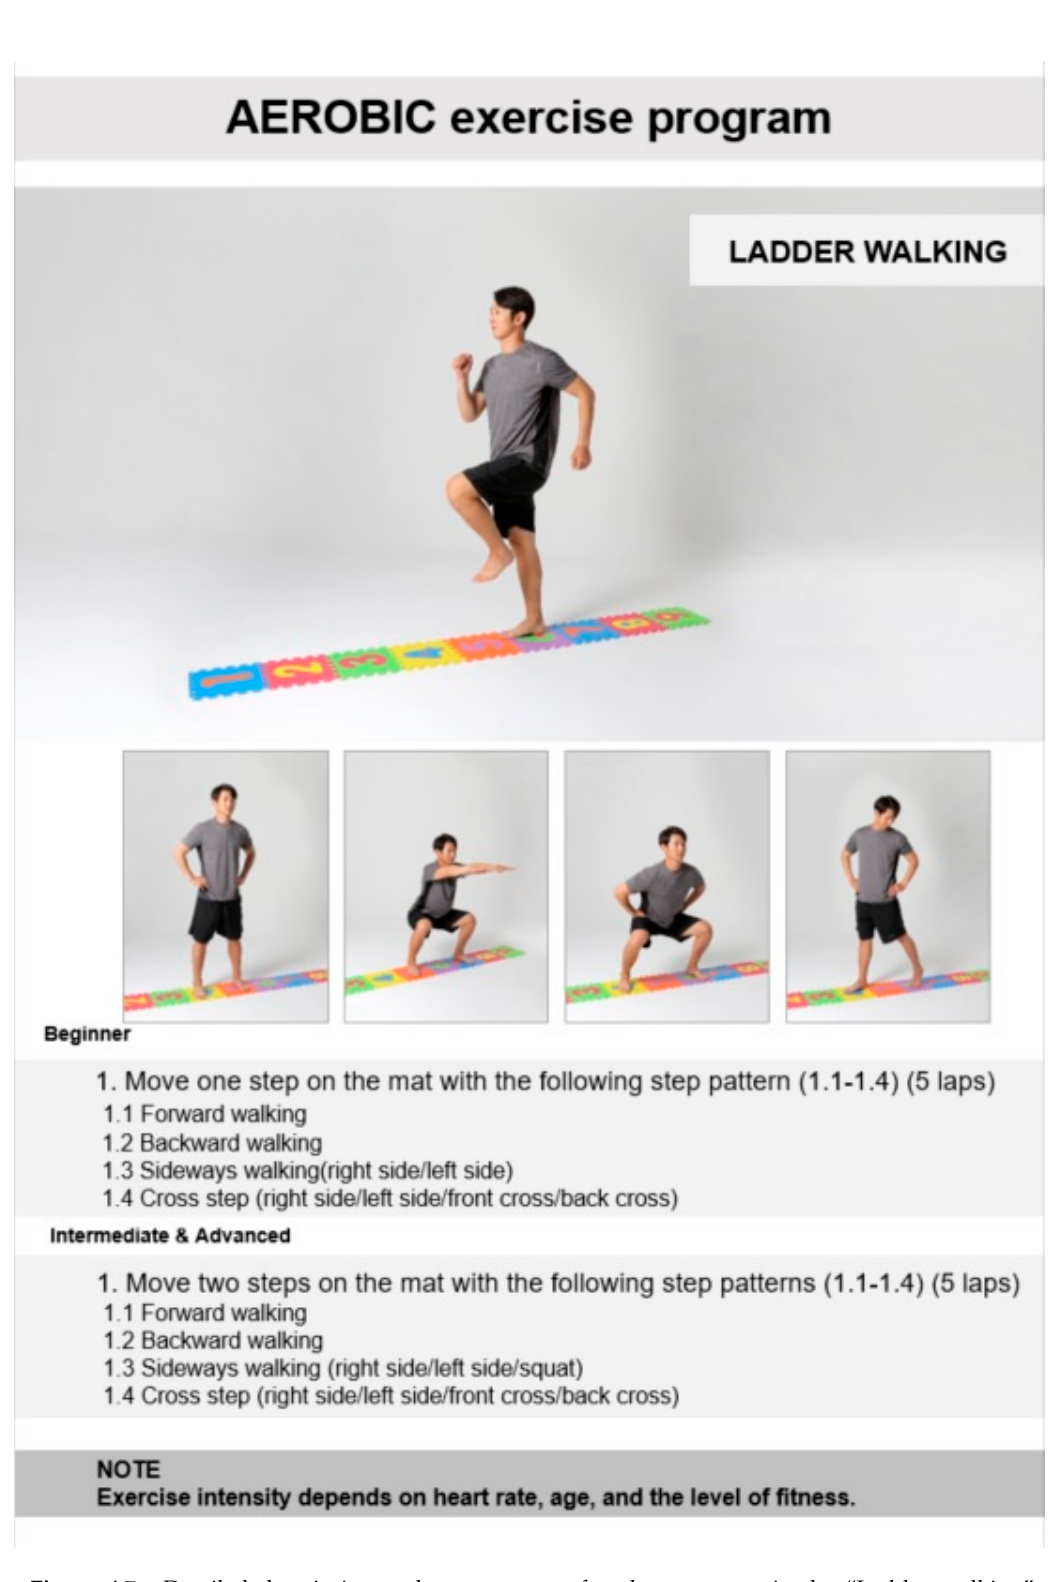
Figure A7. Detailed description and components of each movement in the “Ladder walking” aerobic exercise.